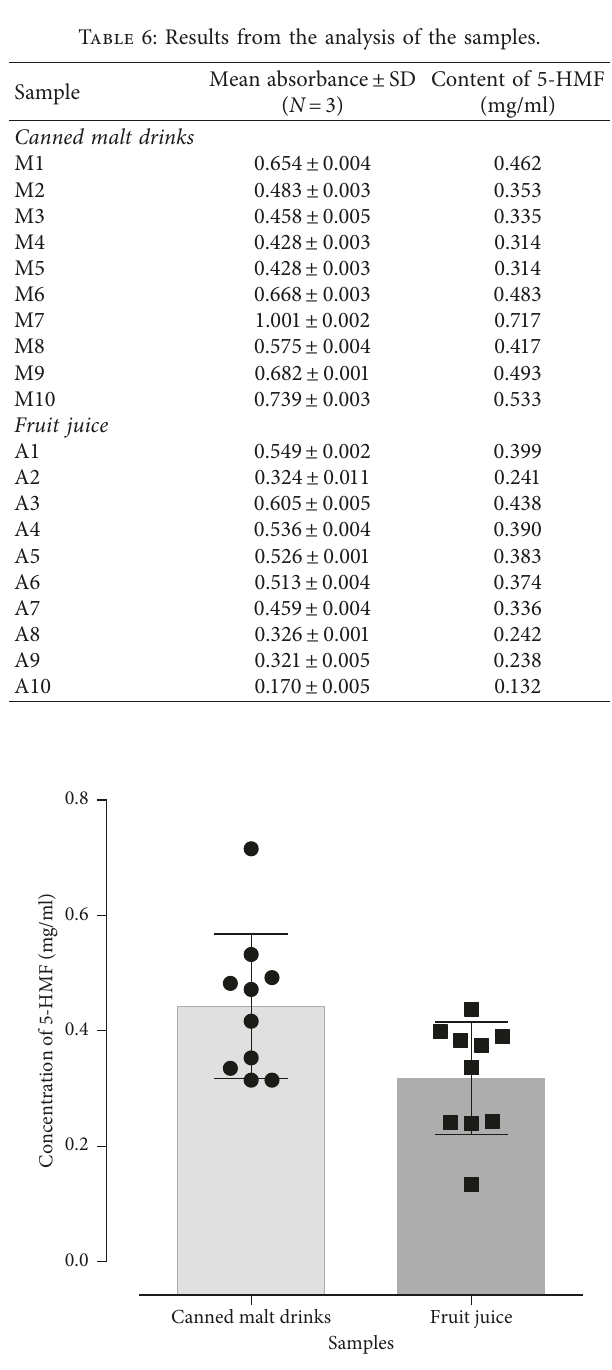
Figure 6: Comparison of the concentrations of 5-HMF in the samples analyzed. Results were presented as mean lyzed using paired Student’s t -test. Comparison of the concentrations